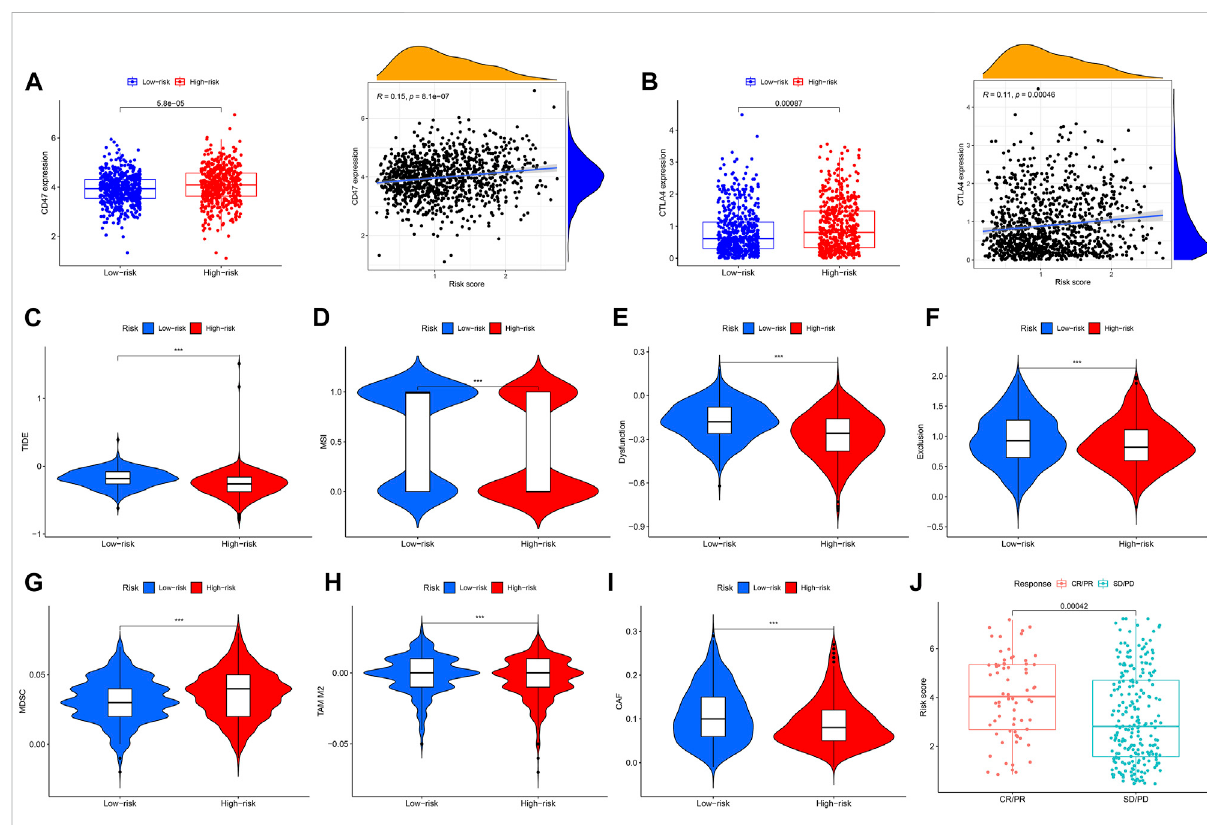
FIGURE 9 CorrelationanalysisanddifferentialexpressionofimmunecheckpointsandTMEscoresinthetwogroups. (A) BarplotofCD47expressioninthe high- and low-risk groups and correlation of risk score and CD47 expression. (B) Bar plot of CTLA4 expression in the high- and low-risk groups and correlation of risk score and CTLA4 expression. (C – I) Values of TIDE, MSI, Dysfunction, Exclusion, MDC, TAM M2, and CAF in the high- and low-risk groups. (J) Comparison of the risk score in the CR/PR and SD/PD groups. CR, complete response; PR, partial response; SD, stable disease; PD, progressive disease, *** p <